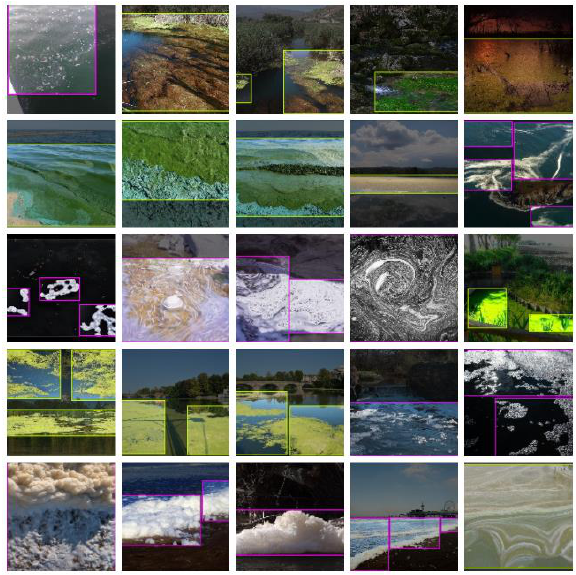
Figure 1 . Sample of dataset images after data